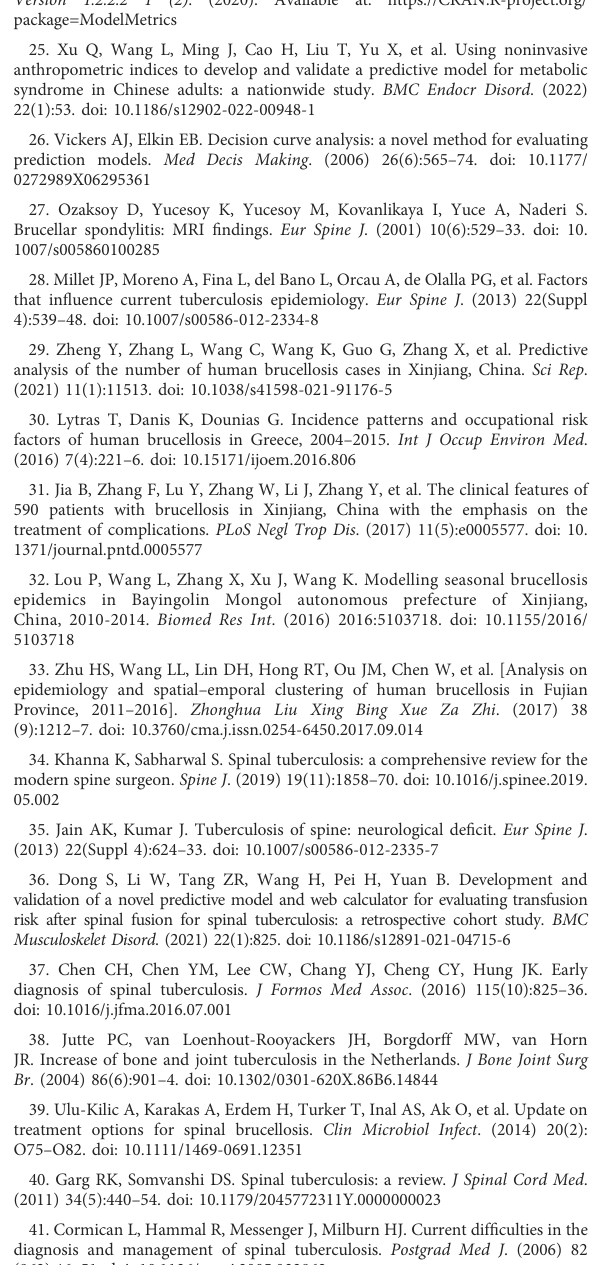
24. Hunt T. Modelmetrics: rapid calculation of model metrics. R Package Version 1.2.2.2 1 (2) . (2020). Available at: